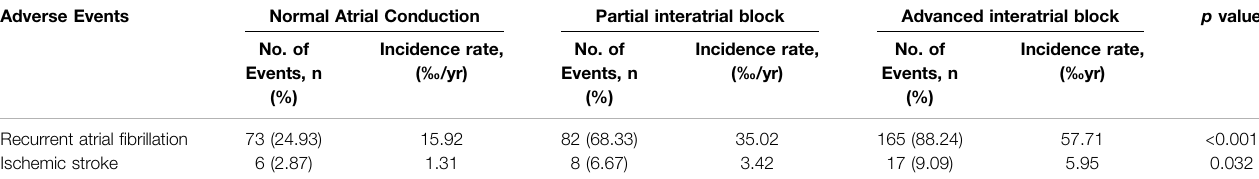
TABLE 3 | Comparison of the rates of adverse events among the study groups. Adverse